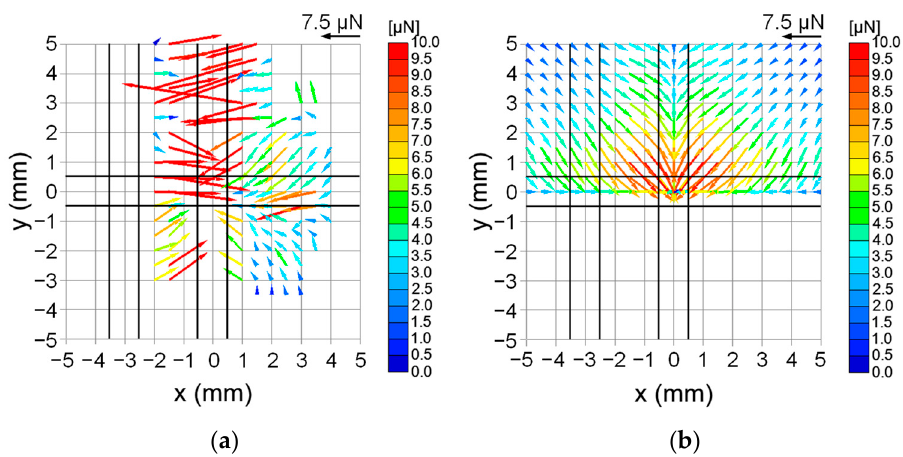
Figure 16. Comparison of electrostatic forces between the experimental and the simulation for the cases where the upper electrode of the initial point is floating: ( a ) Experiment (four times magnified version of Figure 14b with arrows at x = − 1 mm hidden); ( b ) Simulation.